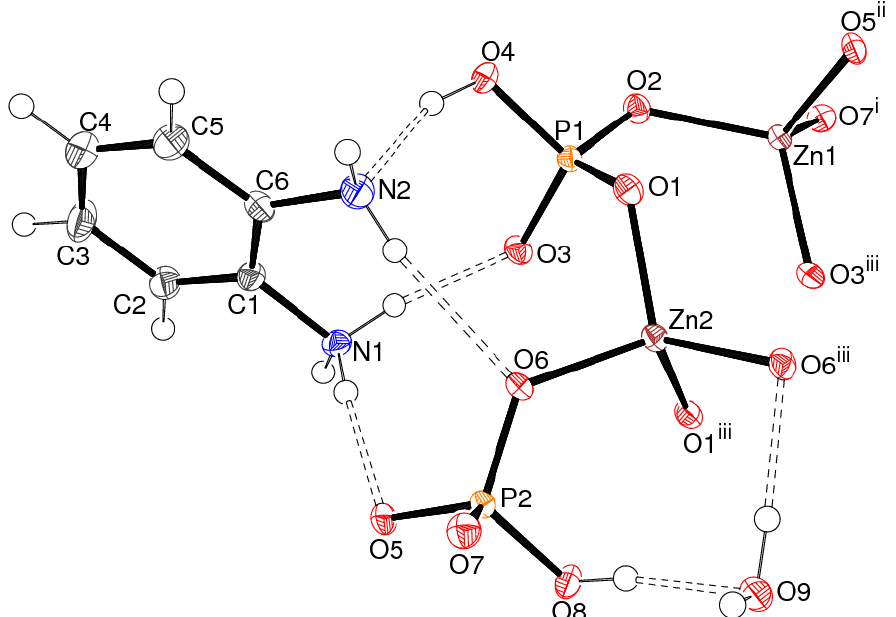
(50% displacement ellipsoids). The hydrogen bonds are shown as double-dashed